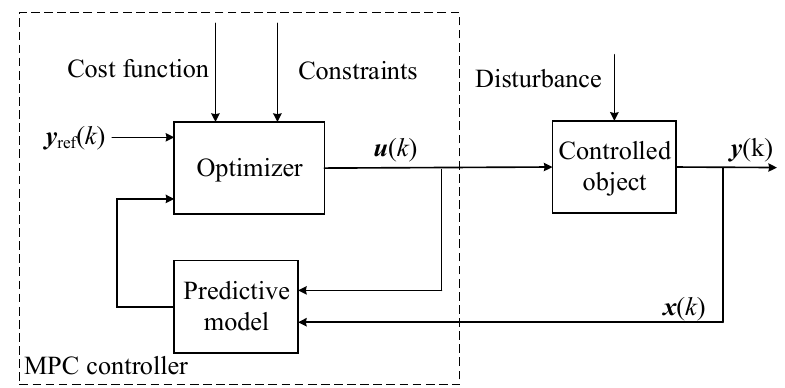
Figure 5. Bump excitation: ( a ) a = 0.1 m; ( b ) a = 0.02 m .